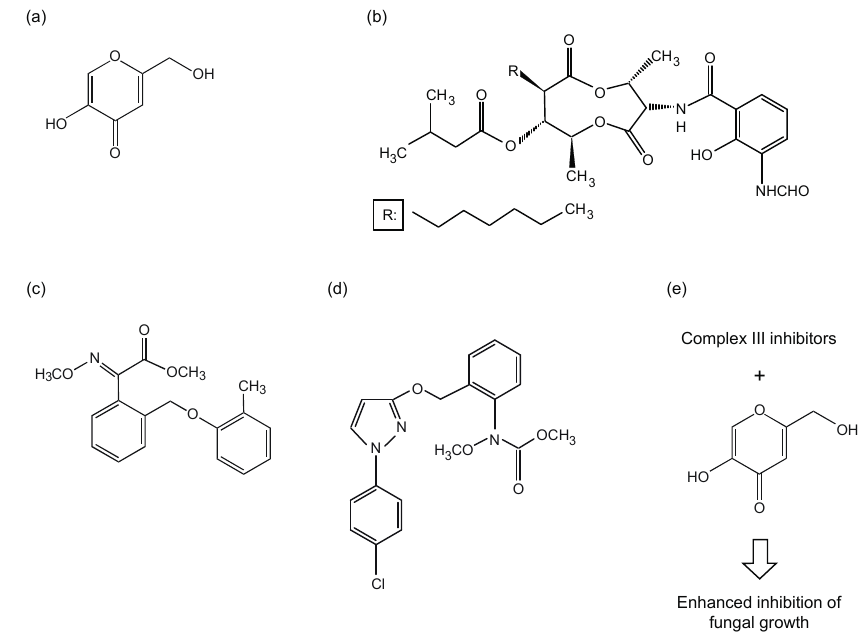
Figure 2. Structures of antifungal compounds examined in this study. ( a ) KA, ( b ) AntA, ( c ) Kre-Me, and ( d ) PCS; ( e ) Scheme for enhancement of antifungal activities of complex III inhibitors by KA-mediated chemosensitization.